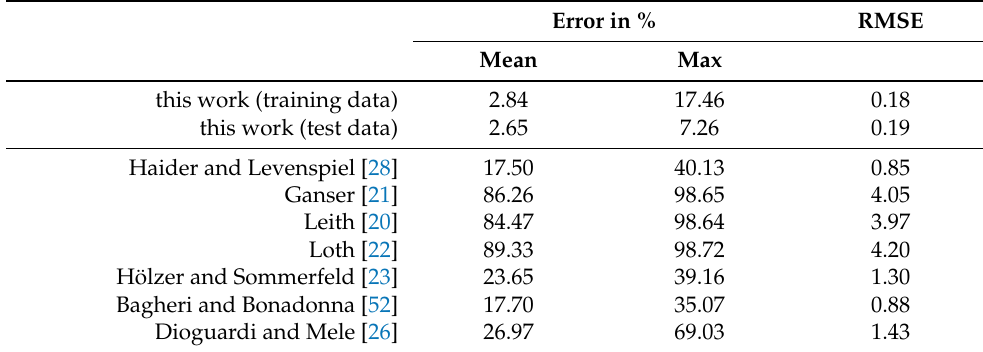
Table 5. Performance of the model obtained by polynomial regression on the training and test data, along with errors of models from literature on the training